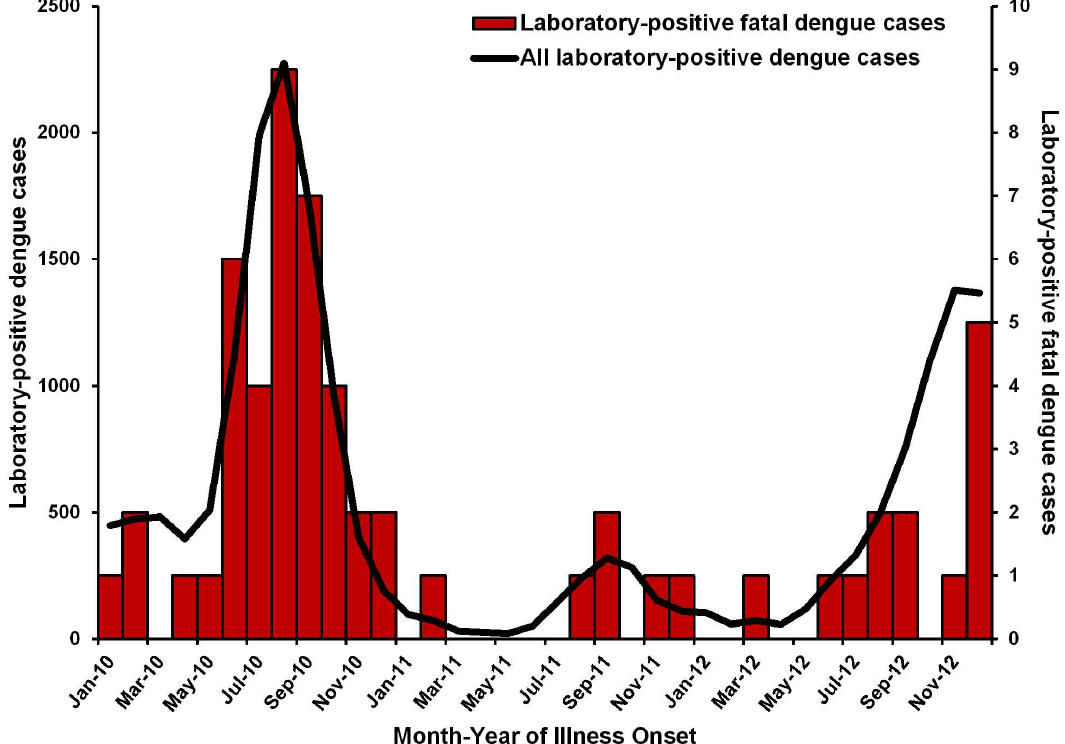
Fig 1. Number of laboratory-positive dengue cases reported to the PassiveDengue Surveillance System and fatal laboratory-positive dengue cases detected by the Enhanced Fatal AFI Surveillance System by month of illness onset, Puerto Rico